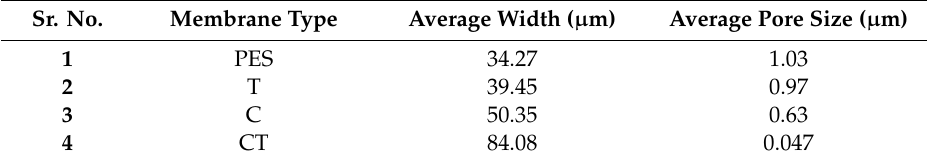
Table 2. Young’s modulus, stress, and strain results for the PES, T-PES, C-PES, and CT-PES membranes. Sr. No.